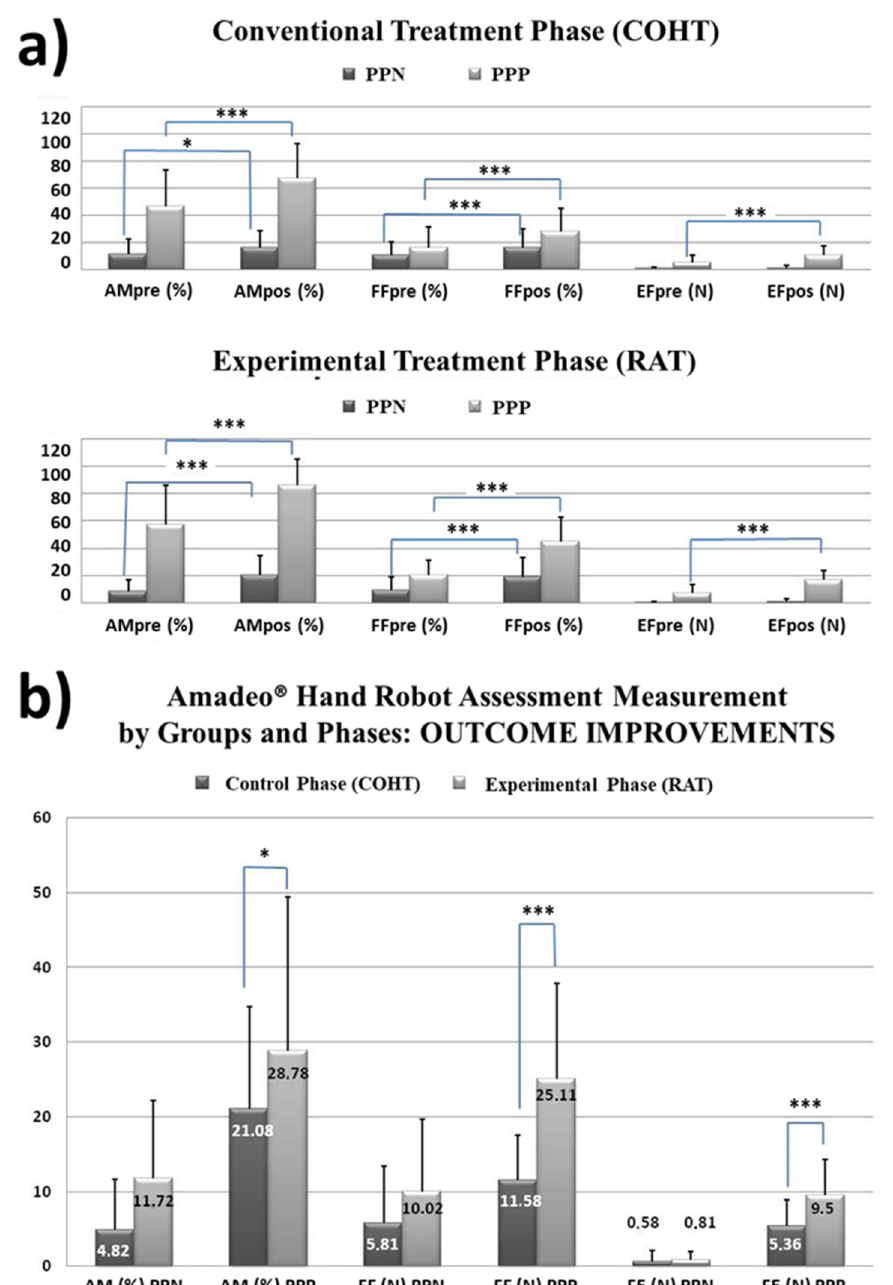
Figure 3. Kinetic and kinematic parameters of the Amadeo ® robot at the baseline and at 3 months ( a ) For both ad hoc prognosis groups, the selected treatments, COHT and RAT, had a similar significant effect for the measured variables. Significance levels for the improvements achieved by group and by treatment phase in the variables measured with Amadeo ® ( b ). Only the PPP group showed statistically significant differences between treatments for the variables AM ( p < 0.05), FF ( p < 0.001) and EF ( p < 0.001). AM: active range of motion; FF: grip flexor strength; EF: extension strength; N: Newton’s of force; %: = percentage of amplitude; PPN: negative prognostic profile group; PPP: positive prognostic profile group . * p < 0.05, *** p < 0.001. (b) Functional sensorimotor results. Statistical results can be seen in Table